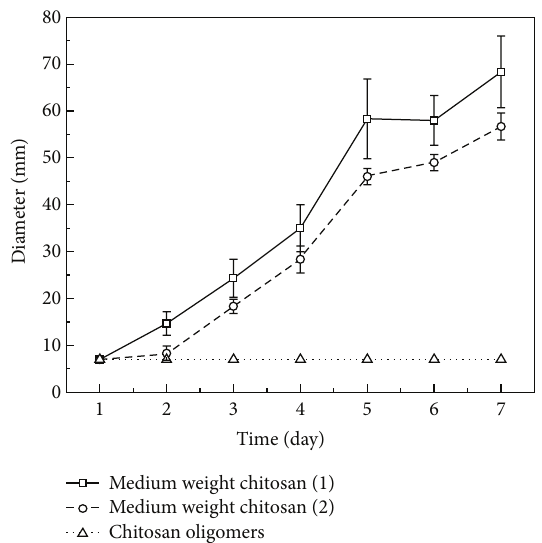
Figure 5: Antifungal action of medium molar mass chitosan (from Sigma Aldrich (1) and from Hangzhou Simit Chemical Technology Co., Ltd. (2)) compared to that of chitosan